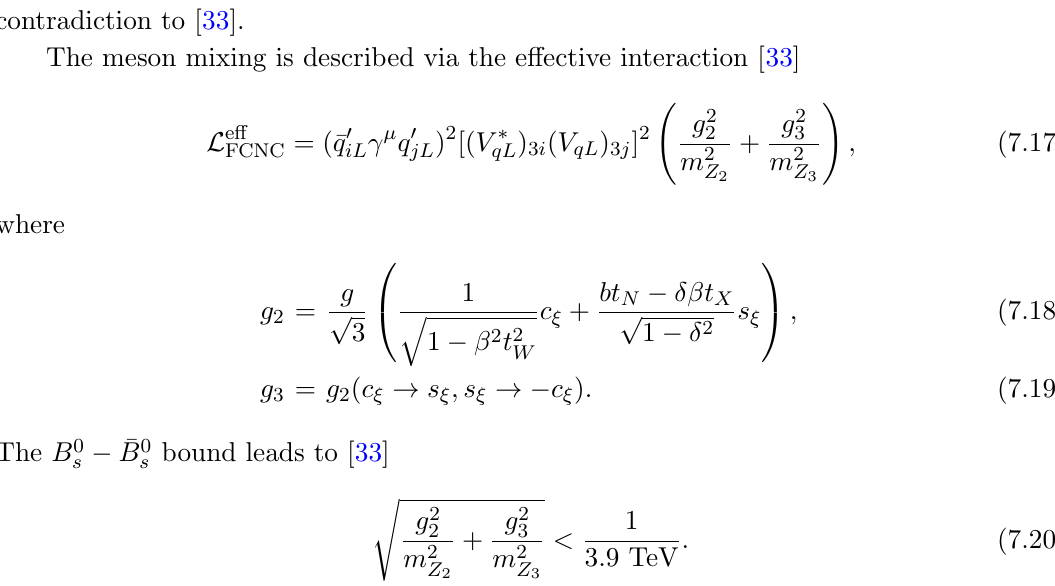
3 , for = 10 (cid:21) 1 , 2 − | | 1 / √ 3, β = 1 / √ 3, and −